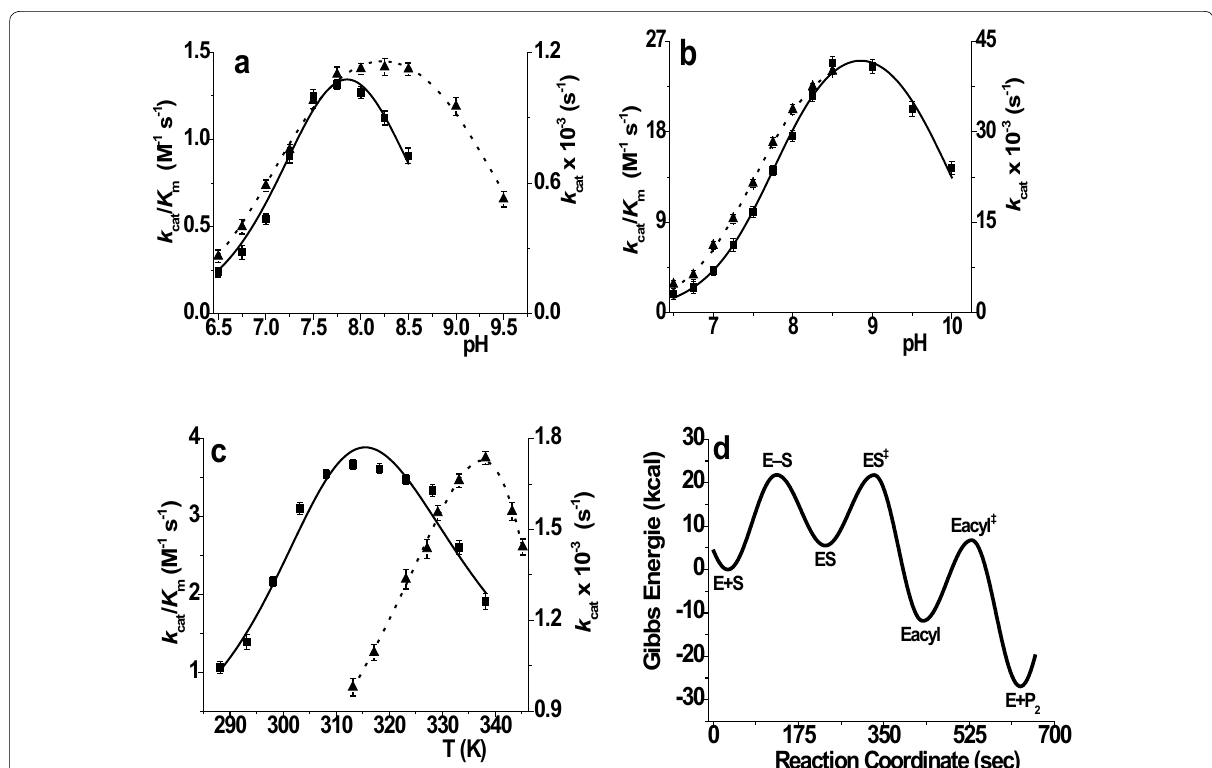
Fig. 6 Kinetic analysis of LipSm. Merged curves of the dependencies of Michaelis–Menten parameters k cat / K m (filled square solid lines) and k cat (filled triangle dotted lines) versus the pH value, as well as versus the absolute temperature, and an energy diagram: a estimates of param‑ eters k cat / K m and k cat versus the pH value, using 4‑nitrophenyl acetate as substrate, where ( k cat / K m ) lim and p K a2 8.29 0.10, as well as ( k cat ) lim = ± k cat / K m and k cat versus the pH value, using 4‑nitrophenyl butyrate as substrate, where ( k cat / K m ) lim p K a2 9.93 0.05, as well as ( k cat ) lim = ± k cat / K m and k cat versus the absolute temperature, using 4‑nitrophenyl acetate as substrate; d energy diagram of hydrolysis of substrate 4‑nitrophenyl acetate by the novel lipase (the value of Arrhenius pre‑exponential factor was assumed as 6